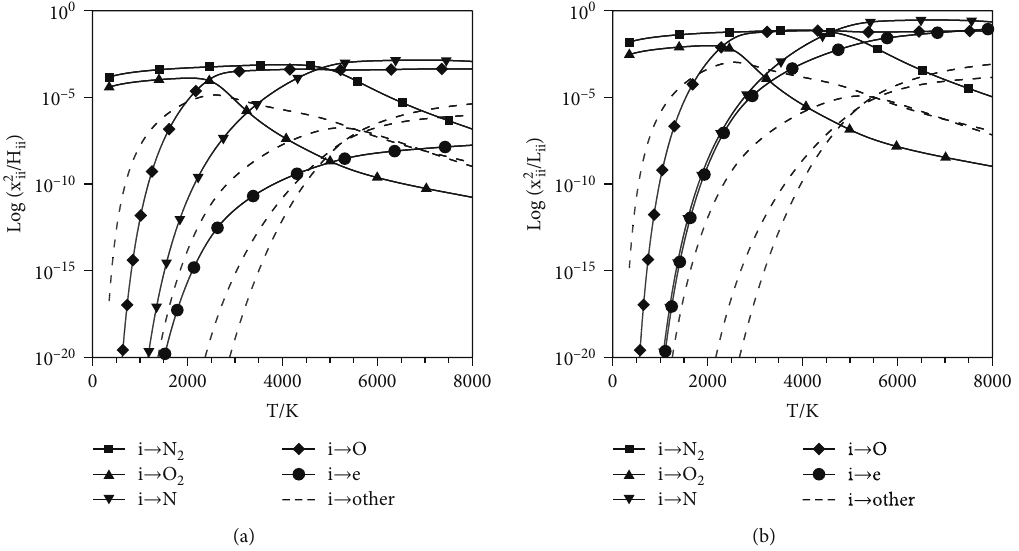
Figure 5: The size of each term of viscosity and translational thermal conductivity coe ffi cients. (a) Viscosity; (b) translational thermal